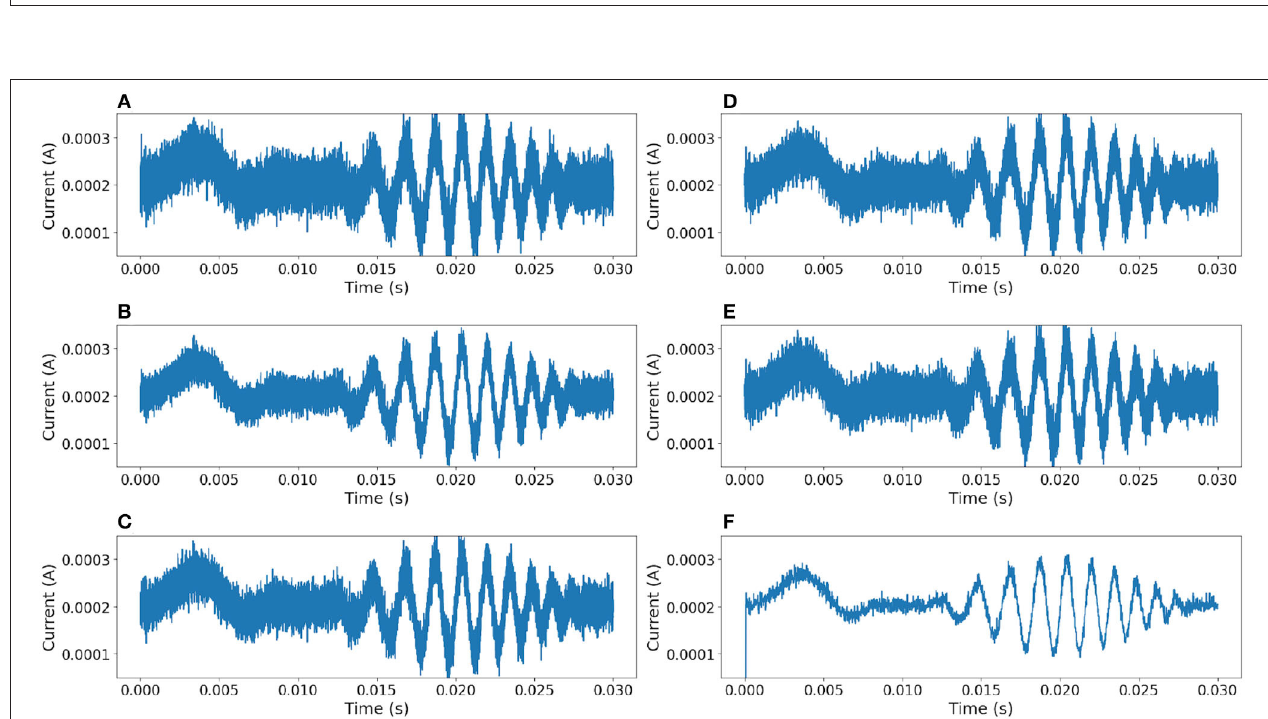
FIGURE 9 | Power Spectral Density graph of the original signal and filter signal by our proposal. We can observe than primary frequencies are presented with low degradation.